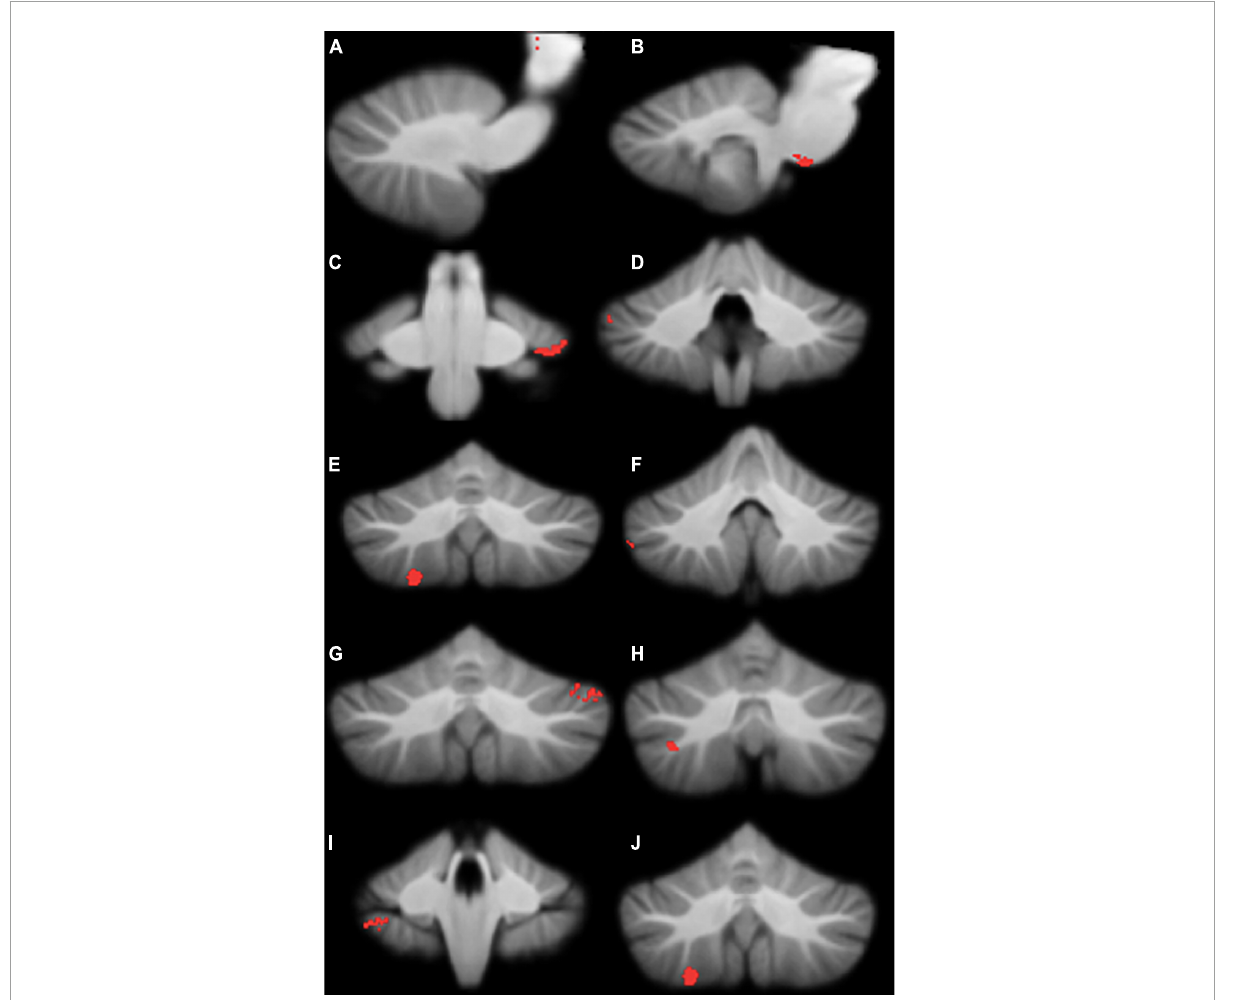
FIGURE2 Significant grey matter reductions in children with developmental coordination disorder (DCD) in comparison to typically-developing children. (A) brainstem; (B) brainstem; (C) left lobule VI; (D) right crus I; (E) right crus I; (F) right crus I; (G) left crus I; (H) right crus II; (I) right lobule VIIb; (J) right lobule VIIIa. All results reported with threshold free cluster enhancement (TFCE) correction, uncorrected across contrast at p < 0.01; cluster size threshold at 50